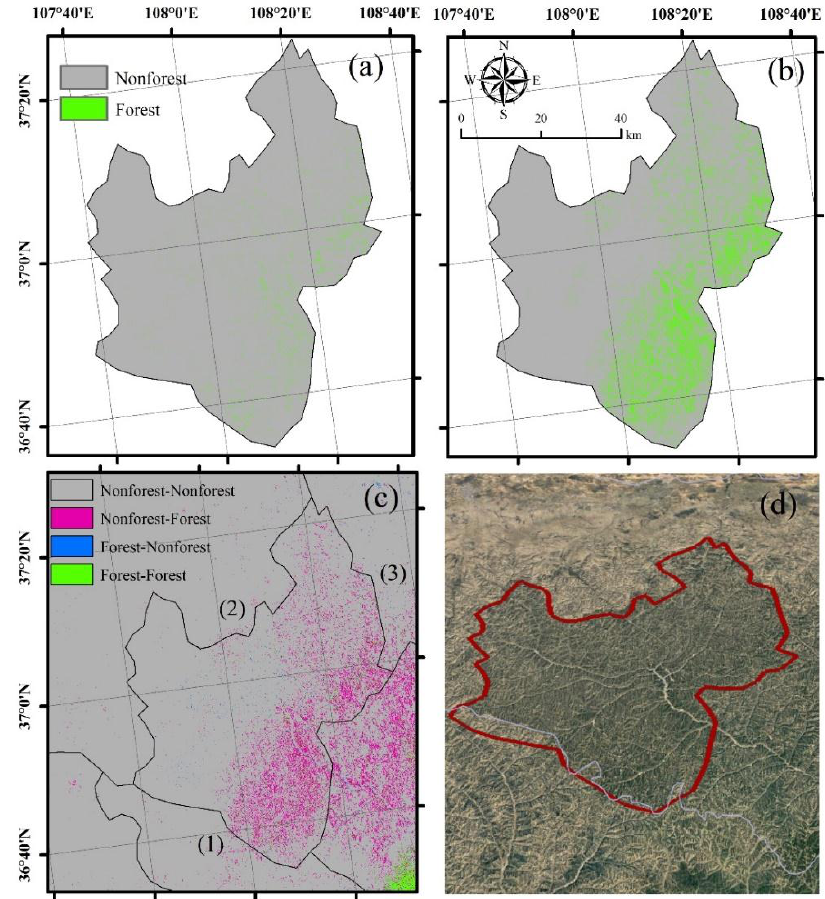
Figure 14. Reforestation in the pilot county (Wuqi County) of the Grain for Green Project (GGP). The forest map of Wuqi County in 2007 ( a ) and 2017 ( b ) the spatial changes of Wuqi County from 2007 to 2017 ( c ), and the image of Wuqi County and the neighboring counties in 2017 from Google Earth ( d ).